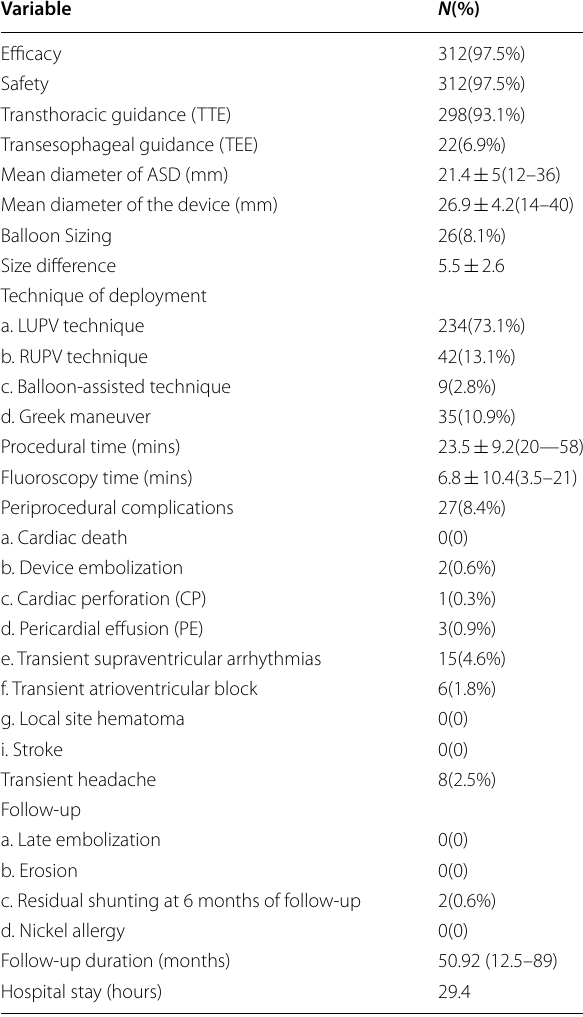
Table 2 Procedure characteristics and outcome of transcatheter closure of atrial septal defect ( N =